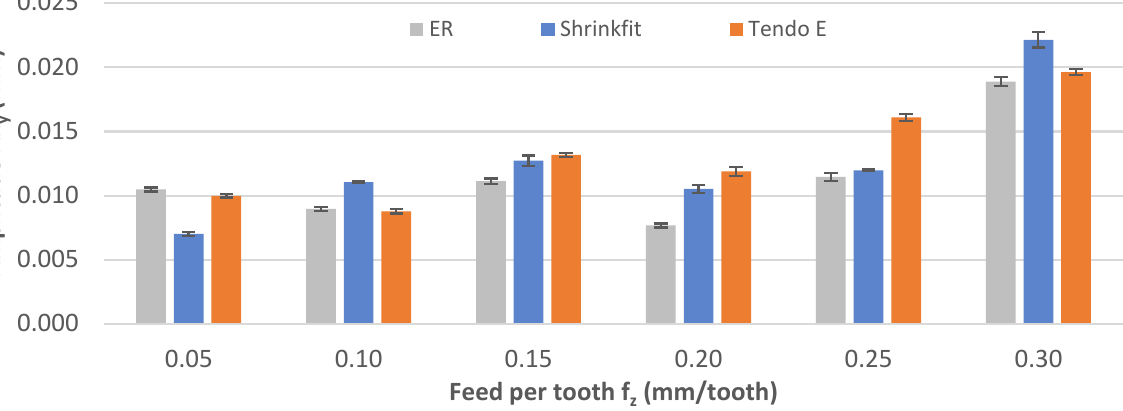
Figure 10. Impact of feed per tooth f z on the vibration displacement amplitude Ax y (v c = 800 m/min, a p = 6 mm). The rms vibration displacement values x y_RMS obtained at a variable feed per tooth are shown in Figure 11. During the machining process, the recorded values were 0.012–0.023 mm, with the lowest feed per tooth of f z = 0.05–0.15 mm/tooth for the heat shrink chuck, f z = 0.20 mm/tooth for the hydraulic chuck, and f z = 0.25–0.30 mm/tooth for the ER collet chuck. Increasing the feed per tooth resulted in a gradual increase in the maximum values, with the exception of f z = 0.20 mm/tooth, which demonstrated a